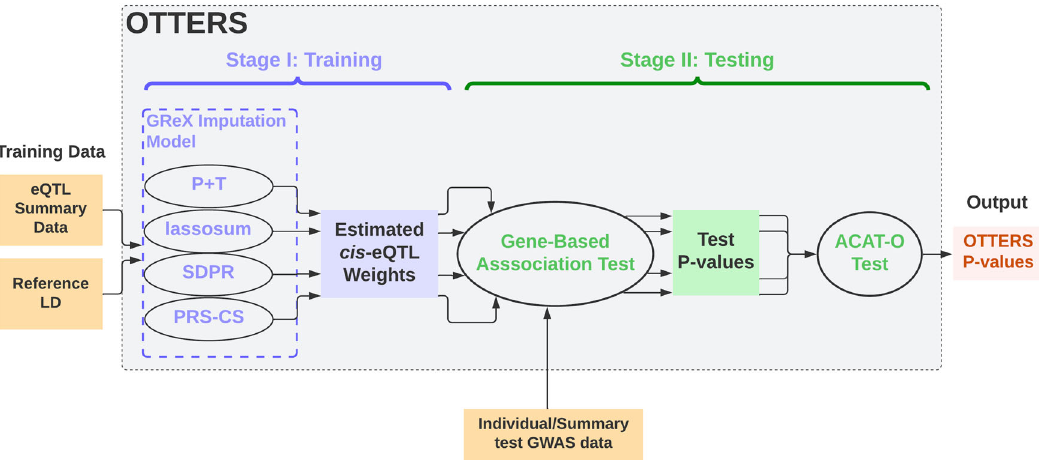
Fig. 1 | OTTERSframework. OTTERS estimates cis-eQTL weightsfrom eQTLsummary dataand reference LDpanelusing fourimputationmodels (Stage I),and conducts ACAT-O test to combine gene-based association test p values from individual methods with individual/summary-level test GWAS data (Stage